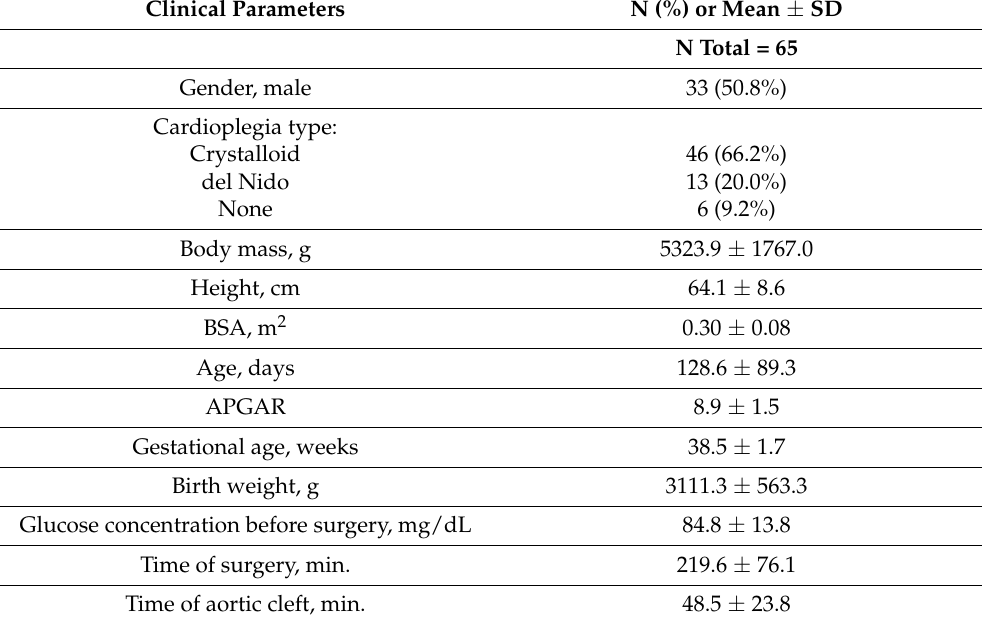
Table 1. Participant